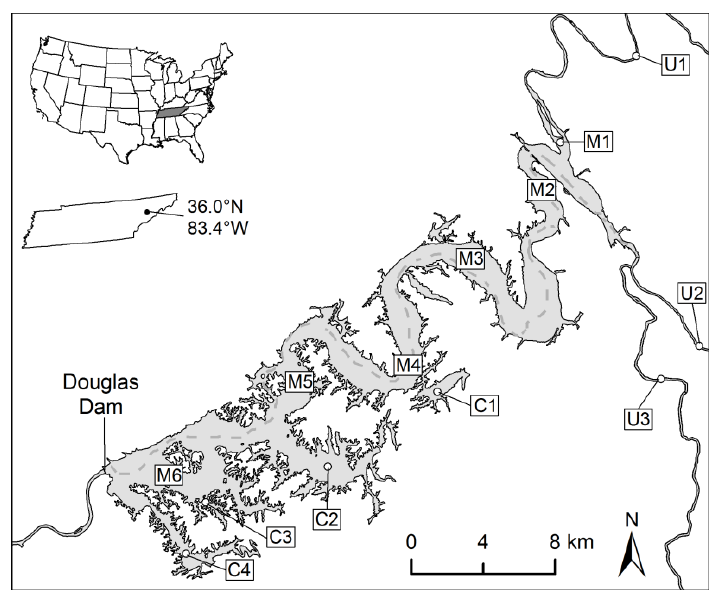
Figure 1. Locations of 13 study sites on Douglas Lake in eastern Tennessee, USA